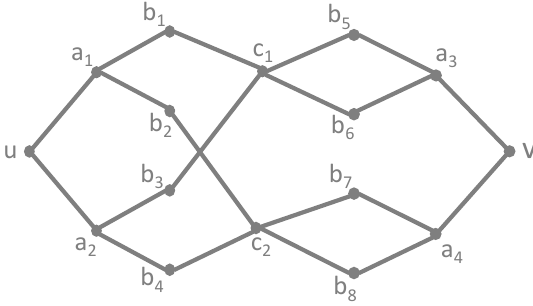
Figure 1. Vertices u and v are regularly equivalent, but not